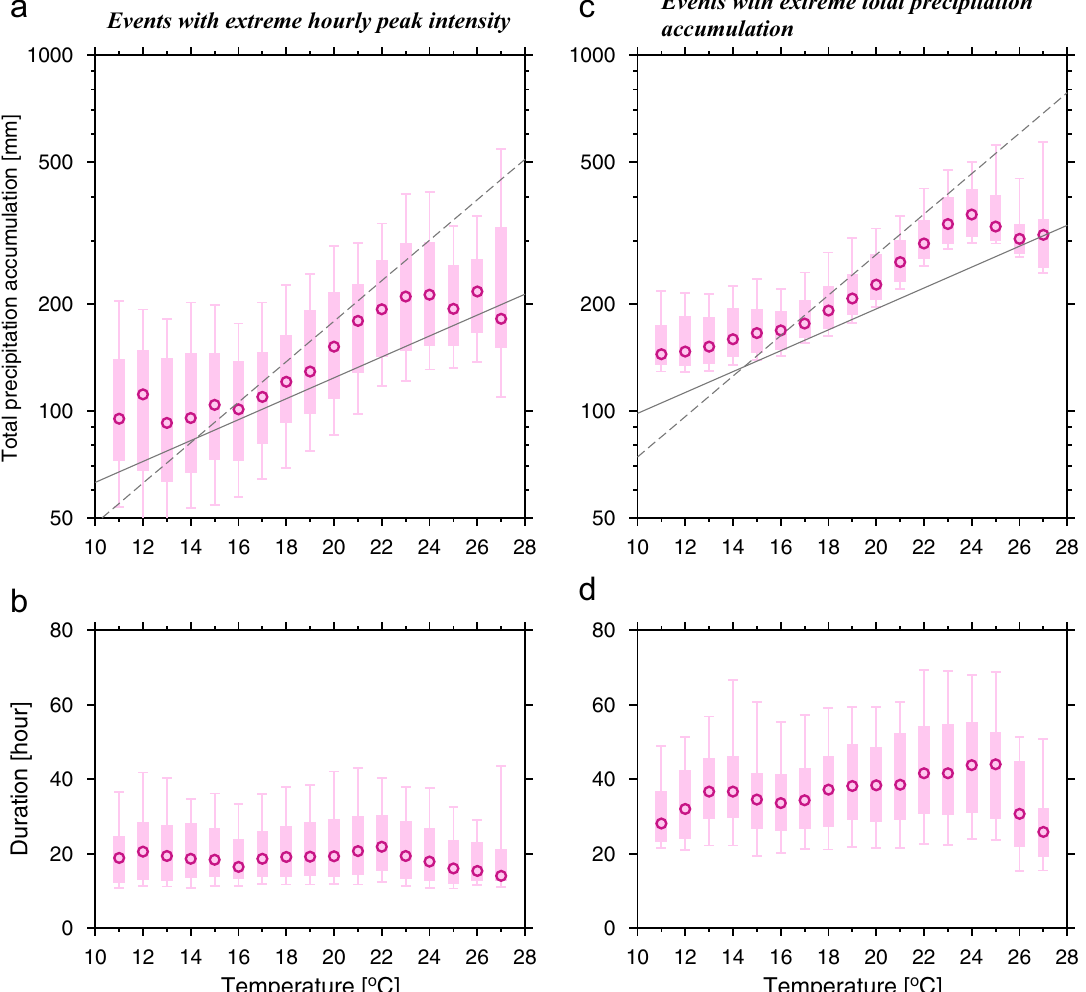
Fig. 4 The relationship between surface air temperature and total-event precipitation amount for long-duration events. a , b Total-event precipitation in long-duration events as a function of daily mean surface air temperature ( a ) and their durations ( b ). In a and b , target events were selected as those showing strong hourly precipitation beyond the 99th percentile for hourly peak intensity at each temperature bin. c , d The same as for a , b but for the events with total-event precipitation accumulations exceeding the 99th percentile. Red circles show the median values of extreme events and box plots show the 10th (bottom horizontal bar), 25th (box bottom), 75th (box top), and 90th (top horizontal bar) percentiles. In a and c , solid and dashed lines indicate 7% °C − 1 and 14% °C − 1 increase, respectively, and a logarithmic vertical axis is